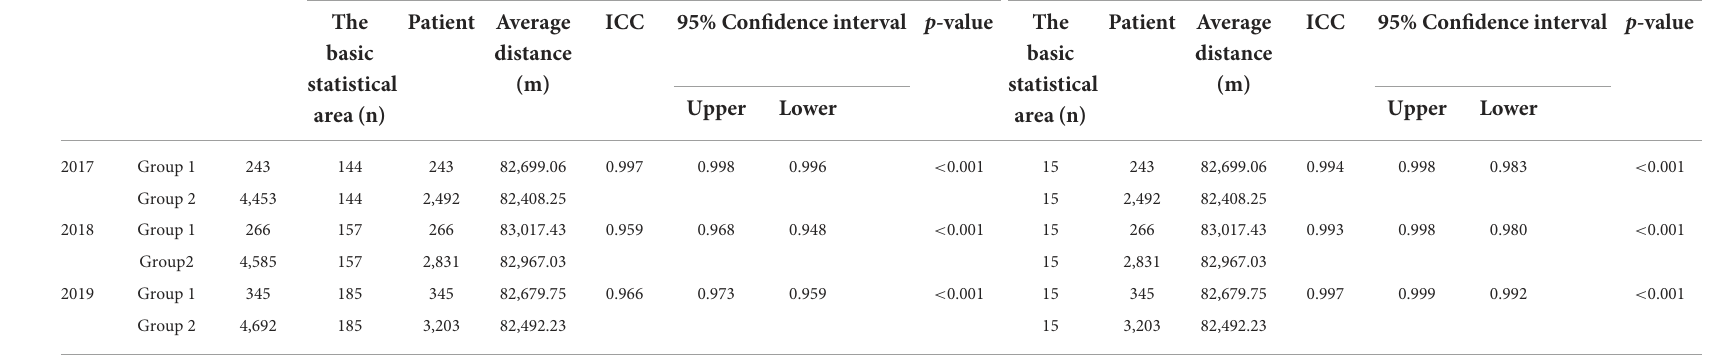
TABLE 7 Predictive accuracy of hypertensive